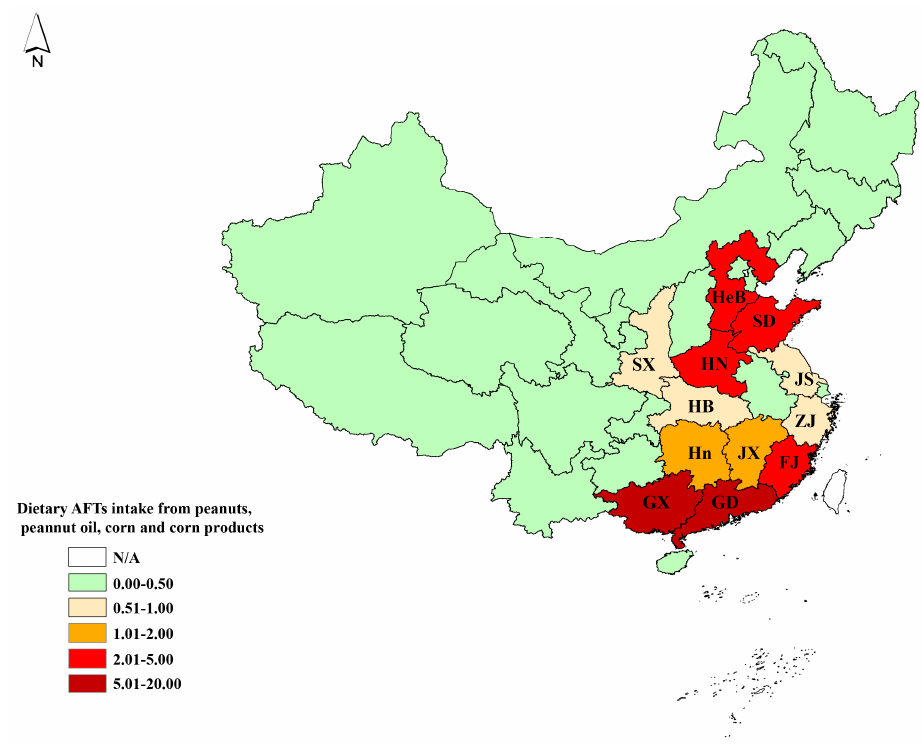
Figure 1. Distribution of the mean daily exposure to AFTs from peanuts, peanut oil, corn, and corn products. HeB: Hebei, HB: Hubei, SD: Shandong, SX: Shaanxi, HN: Henan; JS: Jiangsu; Hn: Hunan, JX: Jiangxi; ZJ: Zhejiang, FJ: Fujian, GD: Guangdong, and GX: Guangxi.